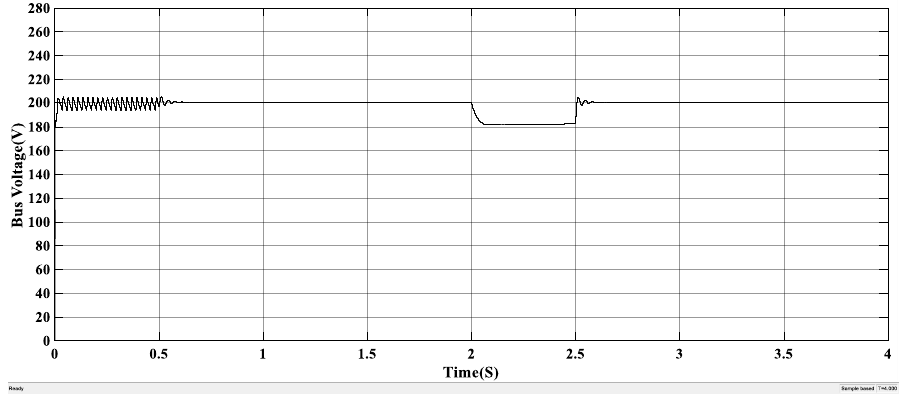
Figure 12. The DC bus voltage waveform in island operation.